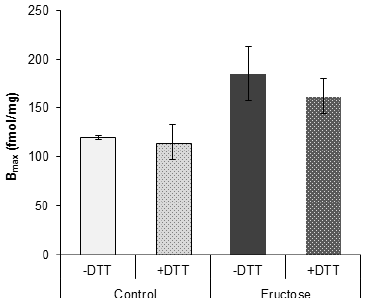
Figure 3. In vitro dexamethasone binding to hepatic GR in the presence and absence of thioprotector. Groups: control (C), fructose-fed (F). Cytosols were incubated (1 h, on ice) in the absence or in the presence of 10 mM DTT and subsequently incubated (18 h, on ice) with 80 nM [ 3 H]dexamethasone in the